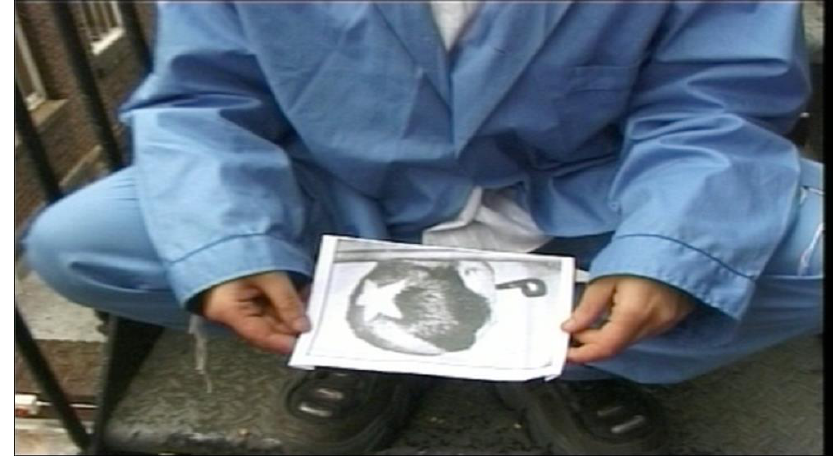
Figure 15. Oreet Ashery, What Is Like for You? , 2000, 04:06. Screen shot, 00:14 min.